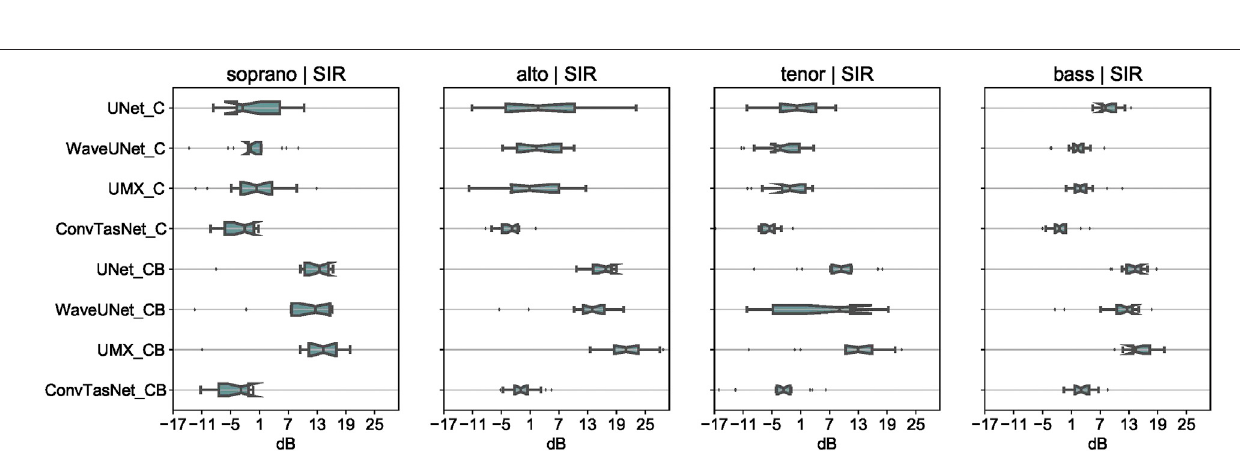
Frontiers in Signal Processing |